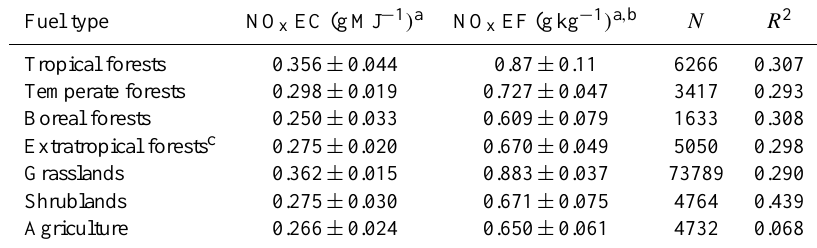
Table 2. Summary of calculated emission coefficients and emission factors for NO x as